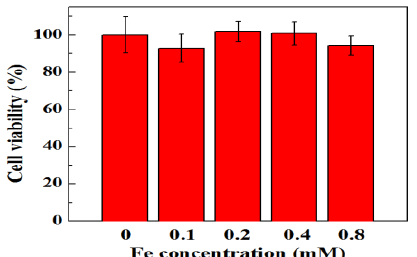
Figure 3. 2,3-Bis-(2-methoxy-4-nitro-5-sulfophenyl)-2 H -tetrazolium-5-carboxanilide (XTT) viability assay of TC-1 cells treated with Fe 3 O 4 modified NEs at Fe concentration of 0 – 0.8 mM for 15 min. TC-1 cells treated with phosphate-buffered saline (PBS) were used as control.